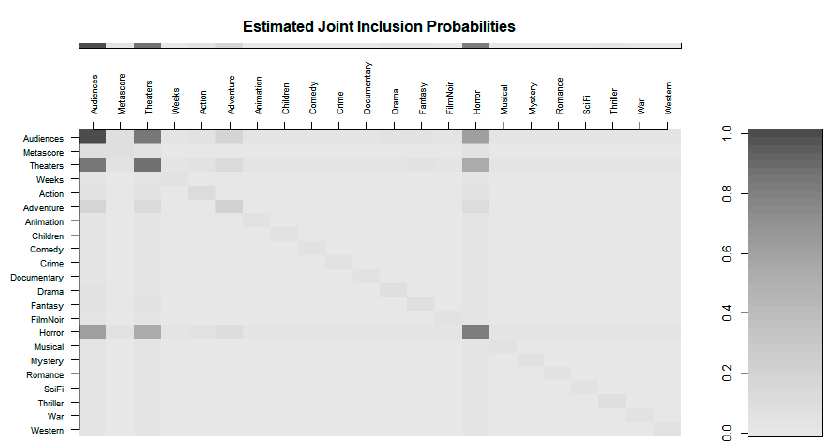
Figure 3. Bayesian variable selection of ROI with Movie Data (2010–2015).